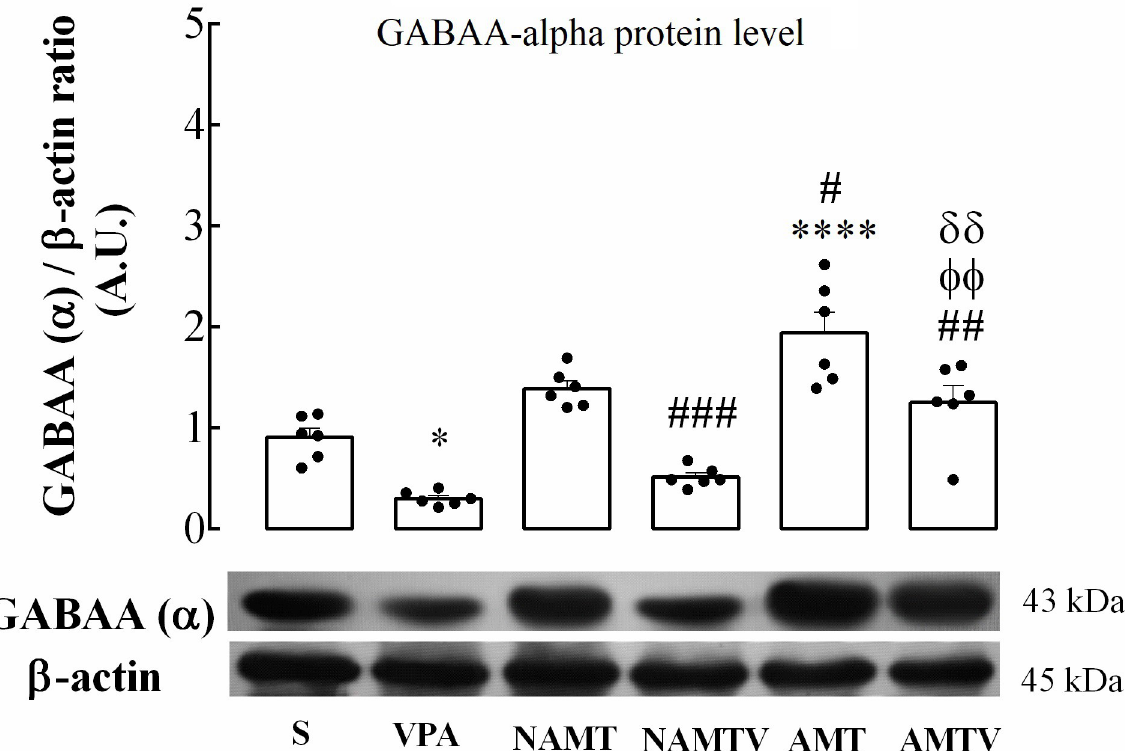
Fig 6. The effects of morphine tolerance and valproic acid pretreatment on hippocampal GABAr α protein density was separated on SDS– PAGE, western blotted, probed with specific primary antibody, and reported with anti β -actin antibody. Data are shown as mean ± SEM, � p < 0.05, �� p < 0.01, ��� p < 0.001, ���� p < 0.0001 compared with control group. #, ϕ , σ indicate a significant difference compared with NAMT, NAMTV and AMT, respectively (one-way ANOVA followed by Tukey’s multiple comparisons test). A.U., S, VPA, NAMT, NAMTV, AMT and AMTV mean arbitrary unit, saline, valproic acid, non-associative morphine tolerance, non-associative morphine tolerance + valproic acid, associative morphine tolerance and associative morphine tolerance+ valproic acid, respectively.